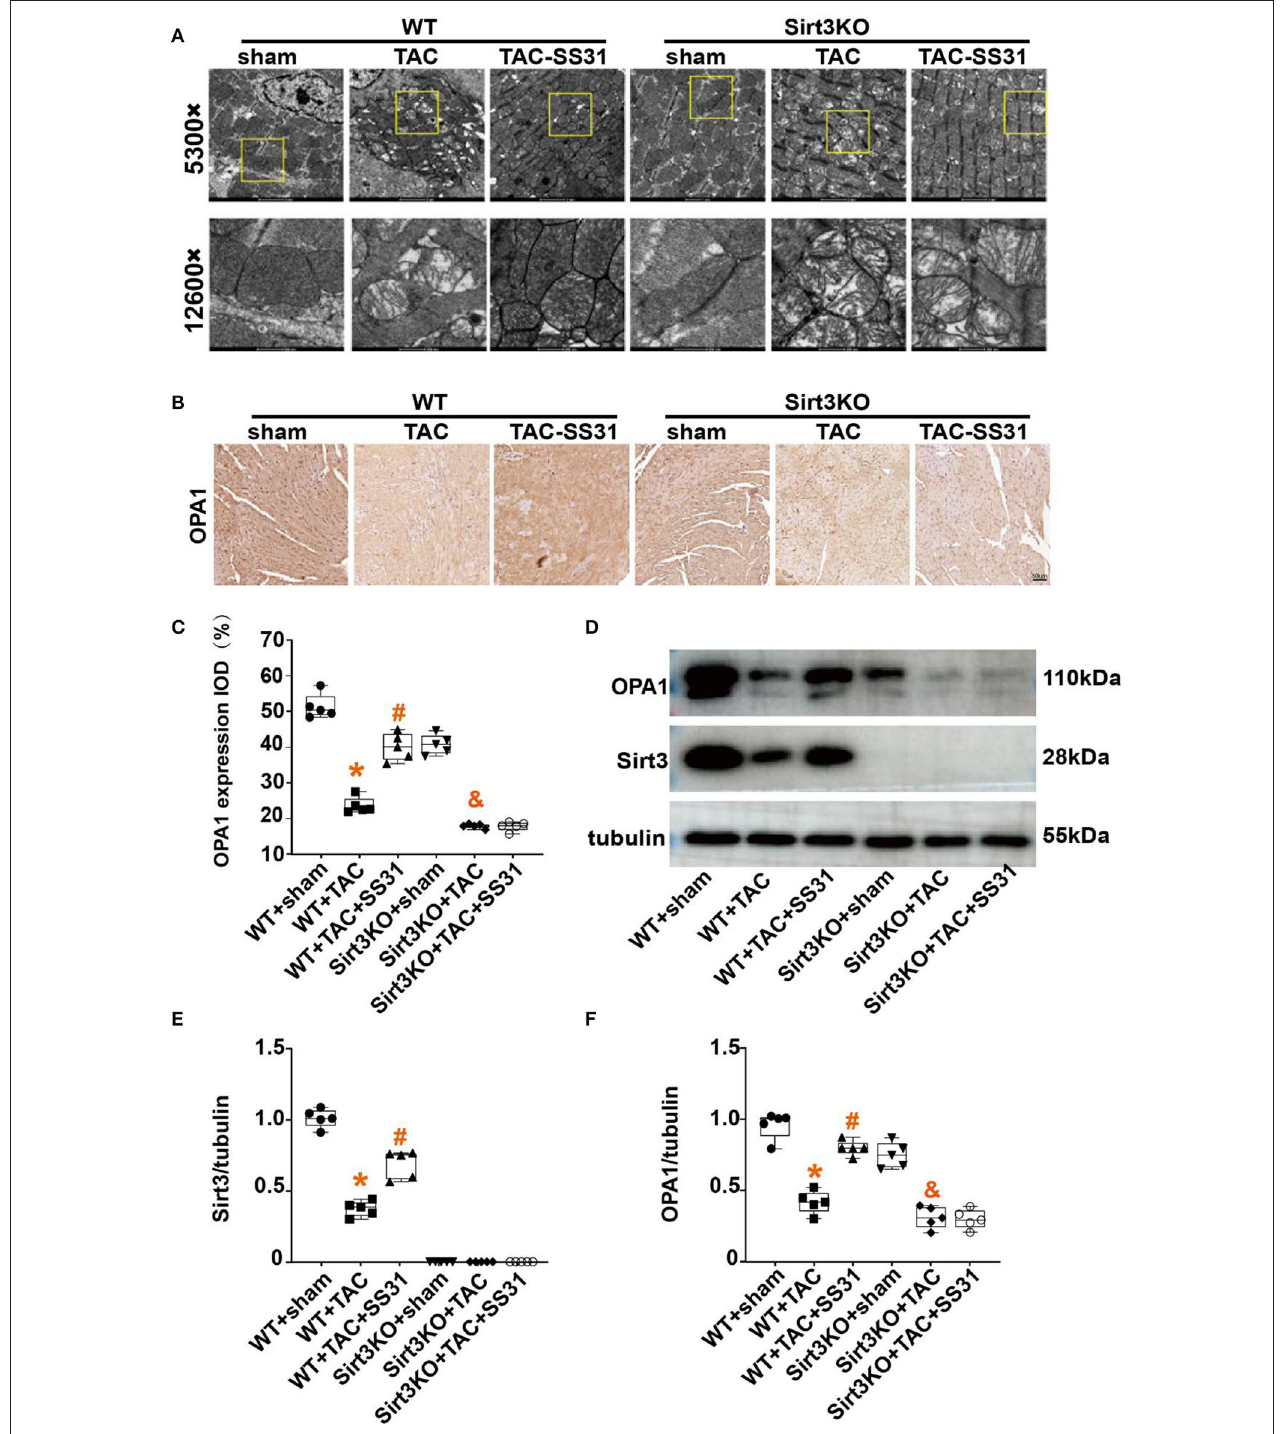
FIGURE 3 | The effect of SS31 on the morphological structure of mouse heart mitochondria. (A) Transmission electron microscope (TEM) observation of myocardial tissue in each group at 8 weeks postoperatively. The image above is a representative evaluation of the left ventricle’s TEM image. (B–F) Observing the effect of SS31 on the expression of mitochondrial fusion protein OPA1 in mouse heart at the molecular level; (B) Immunohistochemical staining of OPA1 in mouse myocardial tissue; (C) Statistical analysis of OPA1 immunohistochemistry; (D) Western blot pictures of Sirt3 and OPA1 of myocardial tissue in mice; (E) Western blot statistical analysis of Sirt3; (F) Western blot statistical analysis of OPA1. (The results are expressed as the means ± SEM, n = 5. The one-way ANOVA test was used, and n represents the number of independent experiments. * p < 0.05 vs. WT + sham group; # p < 0.05 vs. WT + TAC group; & p < 0.05 vs. Sirt3KO + sham group).